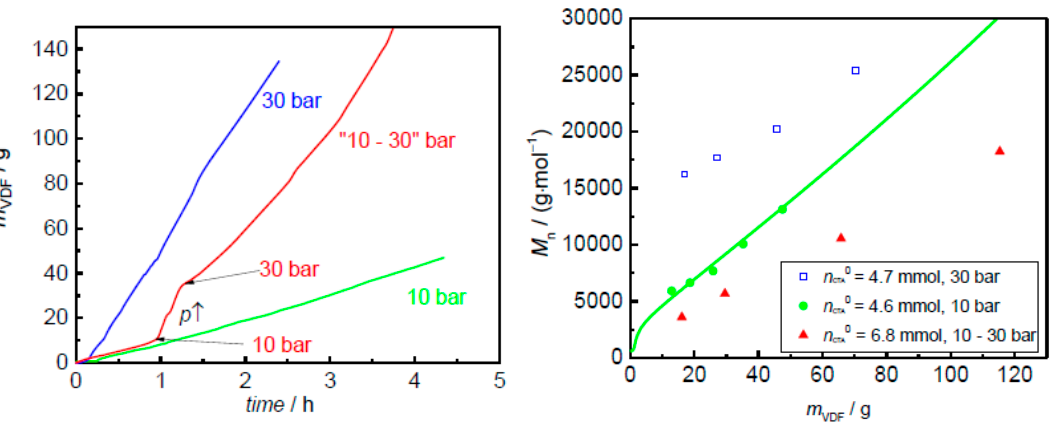
Figure 6. VDF mass fed to the reactor as a function of time during the VDF emulsion polymerization (sample 8–10) at the indicated pressures ( left ) and evolution of number average molar masses, M n , with VDF mass consumed for reactions at 10, 30 bar, and a pressure profile ( right ). The line in the right diagram was obtained via modeling. For further details the reader is referred to the text.